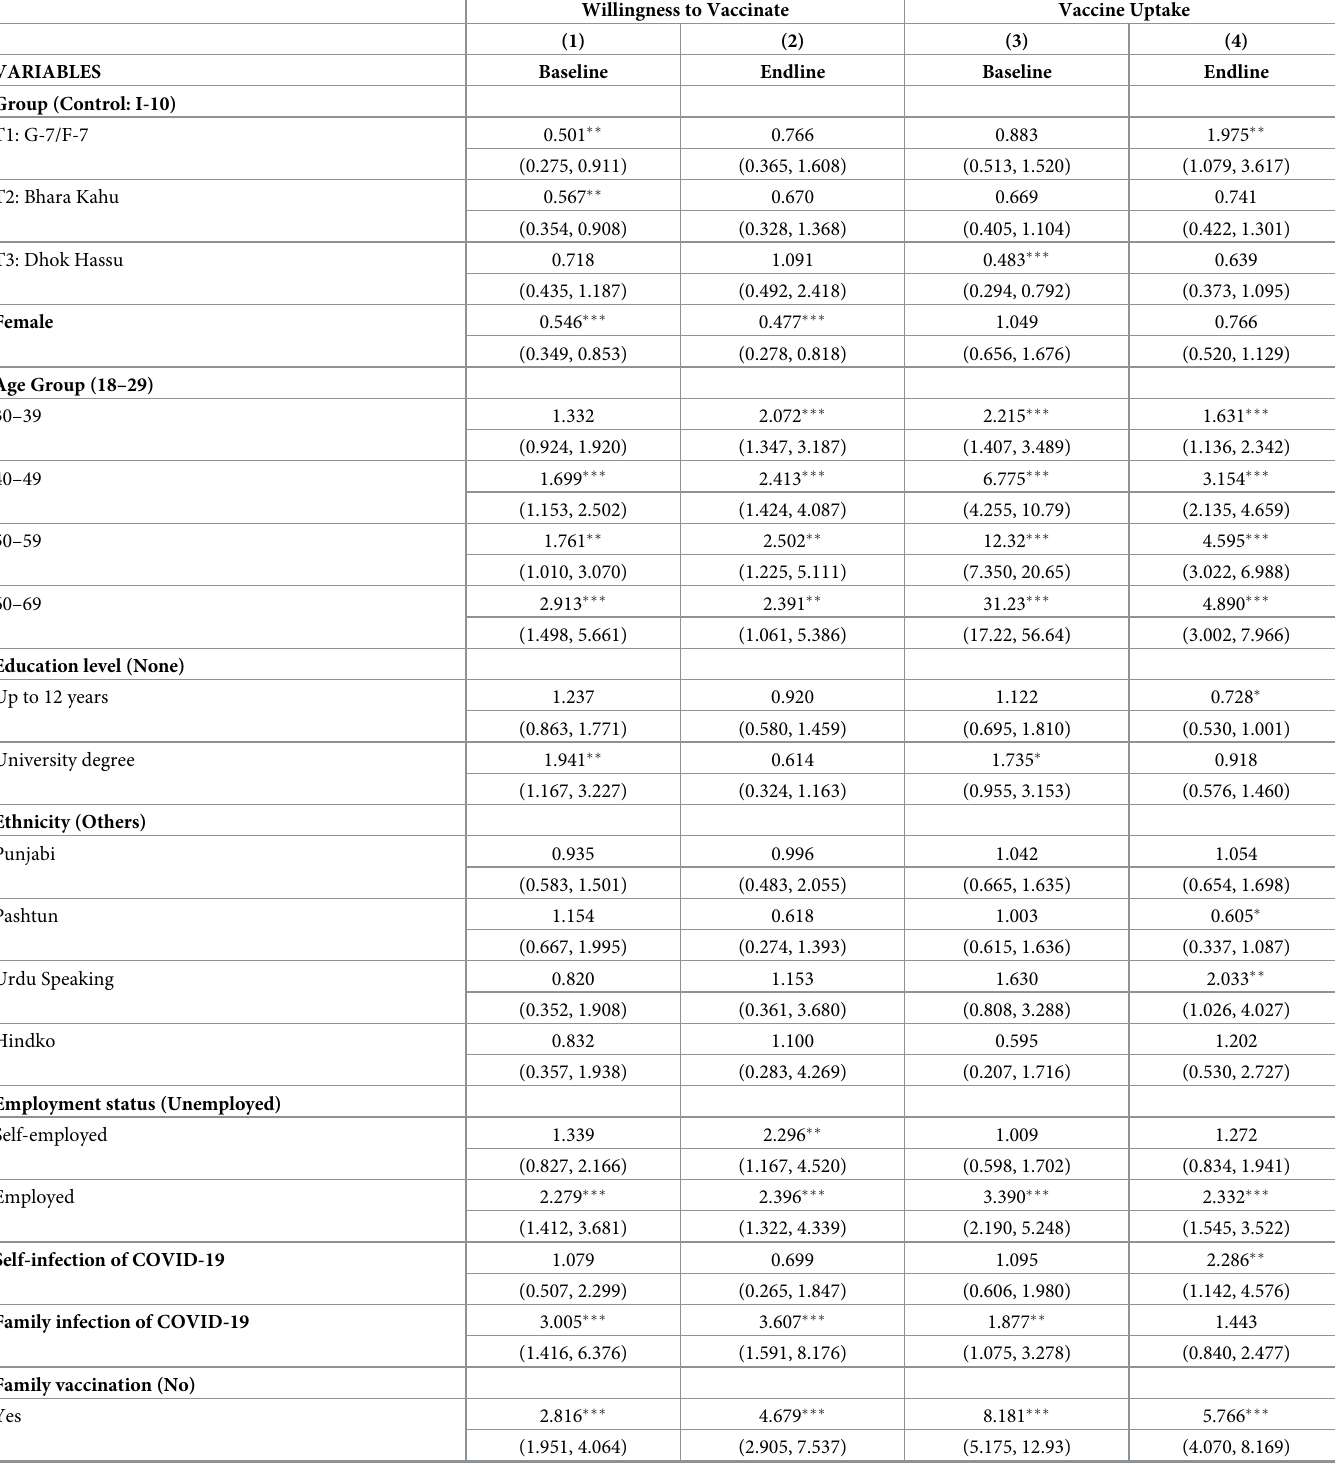
Table 5. Odds ratios of factors influencing willingness to vaccinate and vaccine